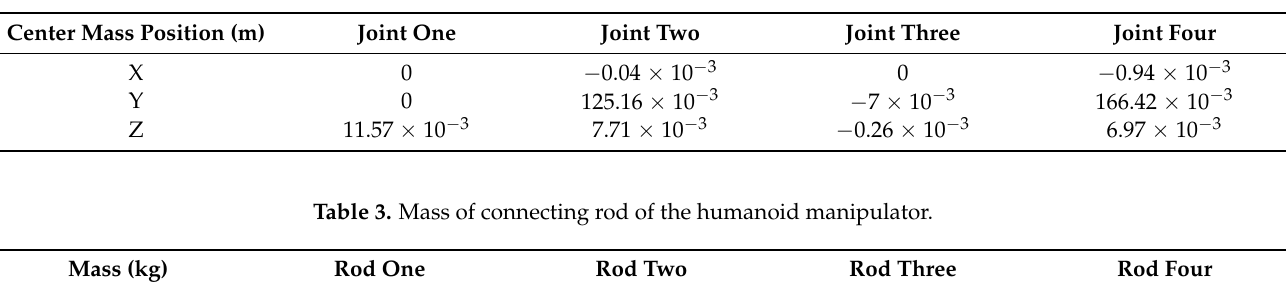
Table 2. The center mass position of the connecting rod.